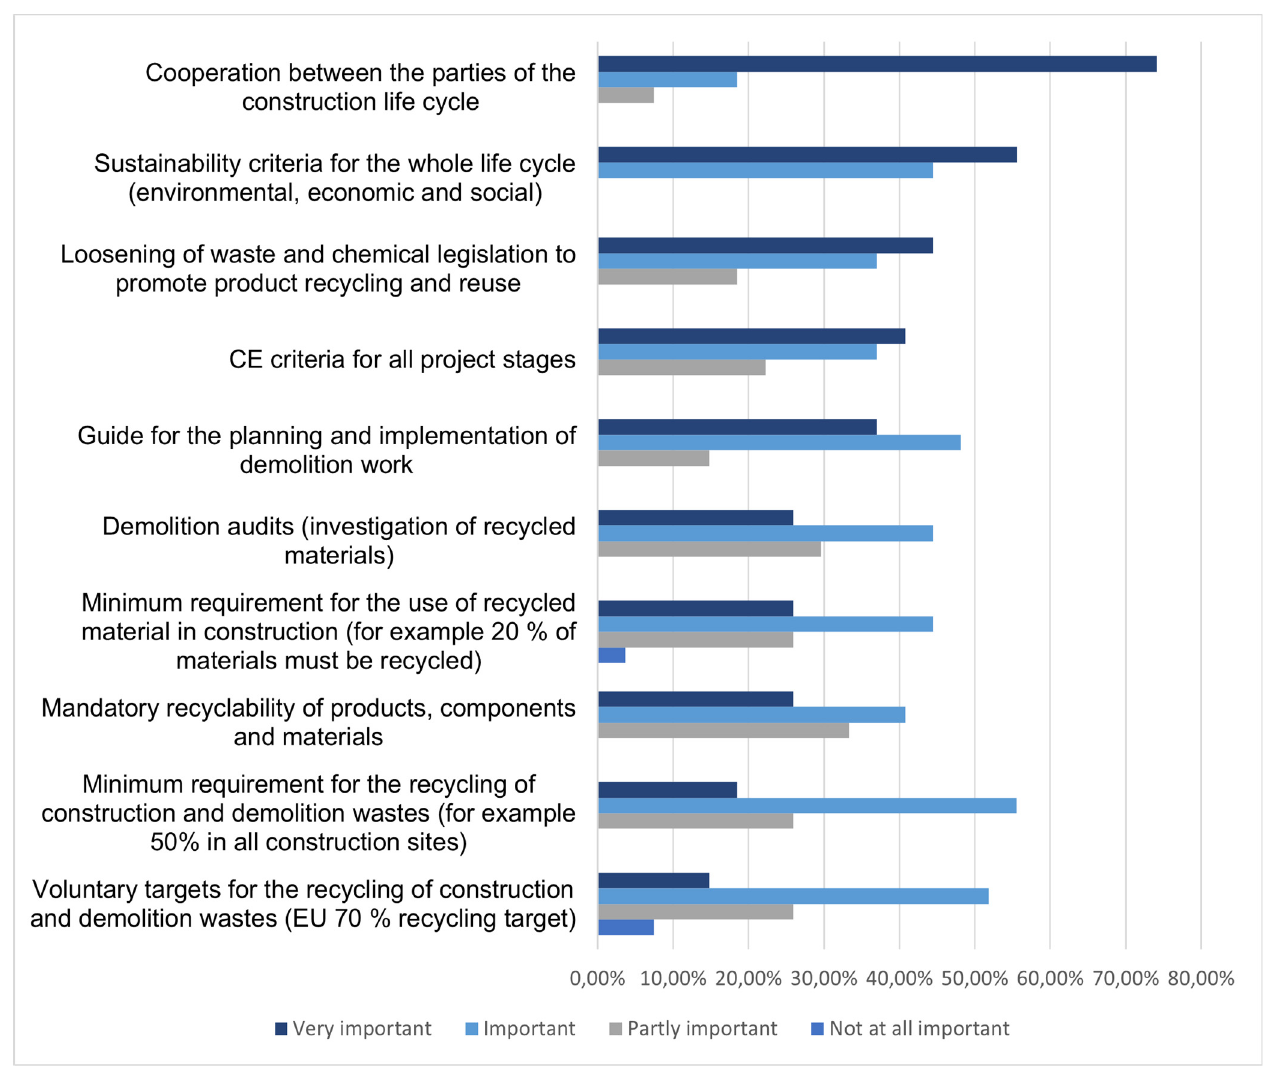
Figure 4. Importance of specific steering approaches for circular economy in the construction sector.